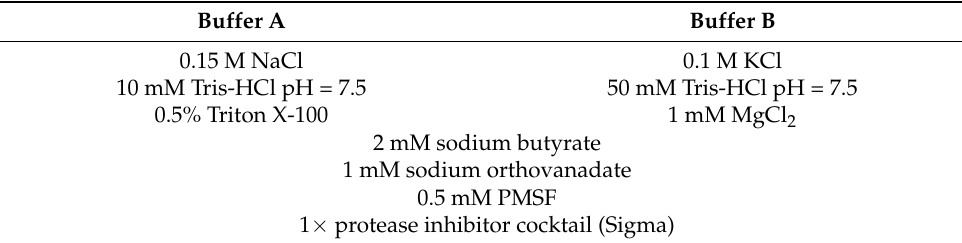
Table 3. Homogenization buffers composition and